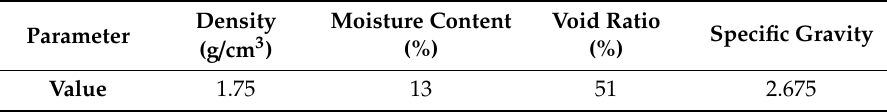
Table 2. Parameters of undisturbed rare earth sample.